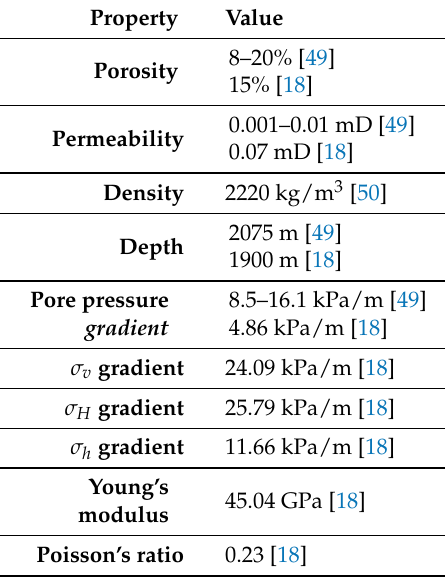
Table 1. The summary of Glauconite data.